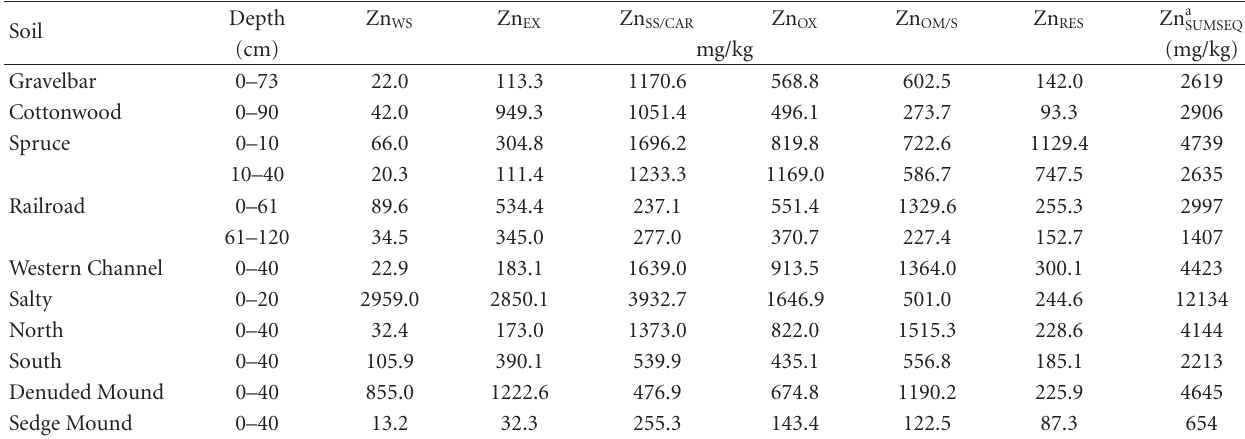
Table 12: Sequential fractionation of Zn in study soils.